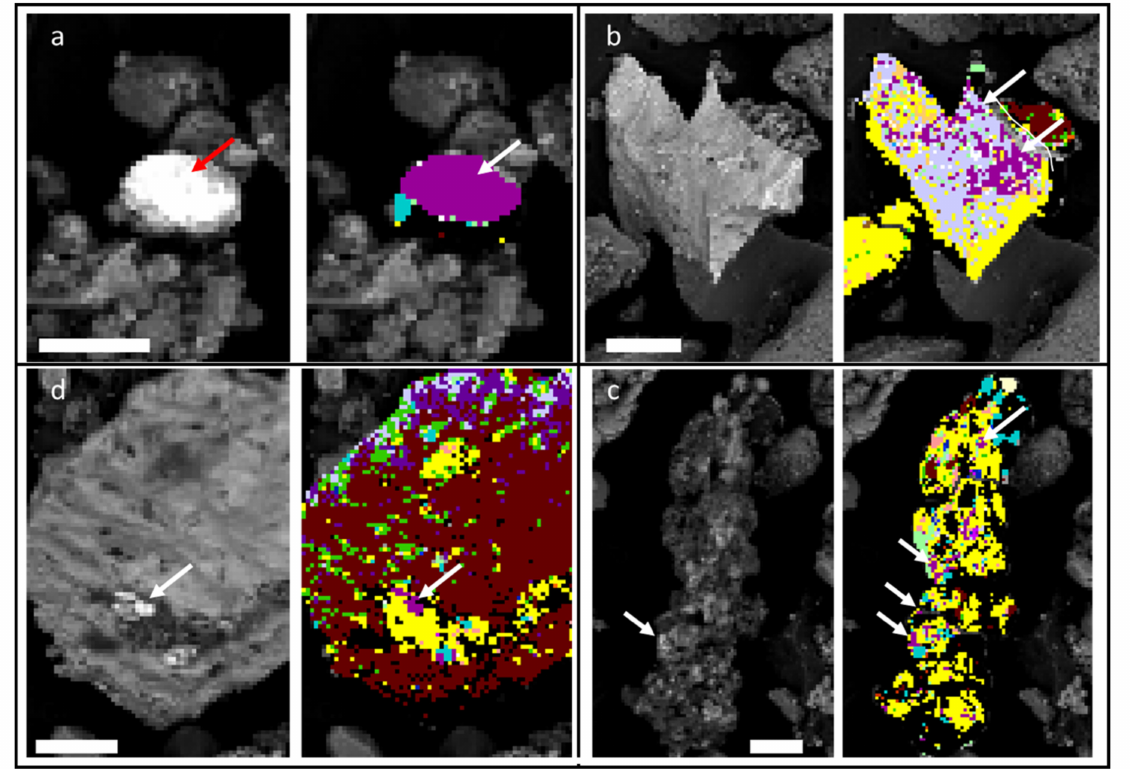
Figure 15. Illustrative imagery of Pb-pixel occurrences in the dust samples, showing for each example (left) BSE and (right) PARC phase map (identical pixel resolution for both images). Arrows indicate Pb-rich pixels in at least the PARC imagery (Pb-rich pixels are coloured dark magenta) and where visible as bright pixels in the BSE images. ( a ) Pb-phase dominated grain belonging to population 111, with superficial adhering NaCl (turquoise). ( b ) Silica-rich grain (from population 114) with large concentration of Pb-rich pixels and Zn-Si rich pixels (lilac) occupying much of its surface, with additional P-Si rich pixels (orange). Yellow {Si} group pixels reflect a silica-dominated substrate. Note conchoidally fractured appearance. ( c ) Composite grain (population 104), comprising numerous smaller sub-grains of natural silicate (primarily quartz (yellow)) and FeOx (dark brown), with superficial NaCl (bright blue), sulphate (light green) covering, and several clear, distinct Pb-rich sub-grains. The dark regions within the grain shown in ( c ) are empty spectra pixels and represent a combination of topography and detector-shadow artefacts and potentially organic material between the other detected phases. ( d ) Iron-ore sinter grain with discrete Pb-rich sub-grains, also clearly visible in BSE image as bright regions. The scale bars in all images denote 20 pixels = 32 µ